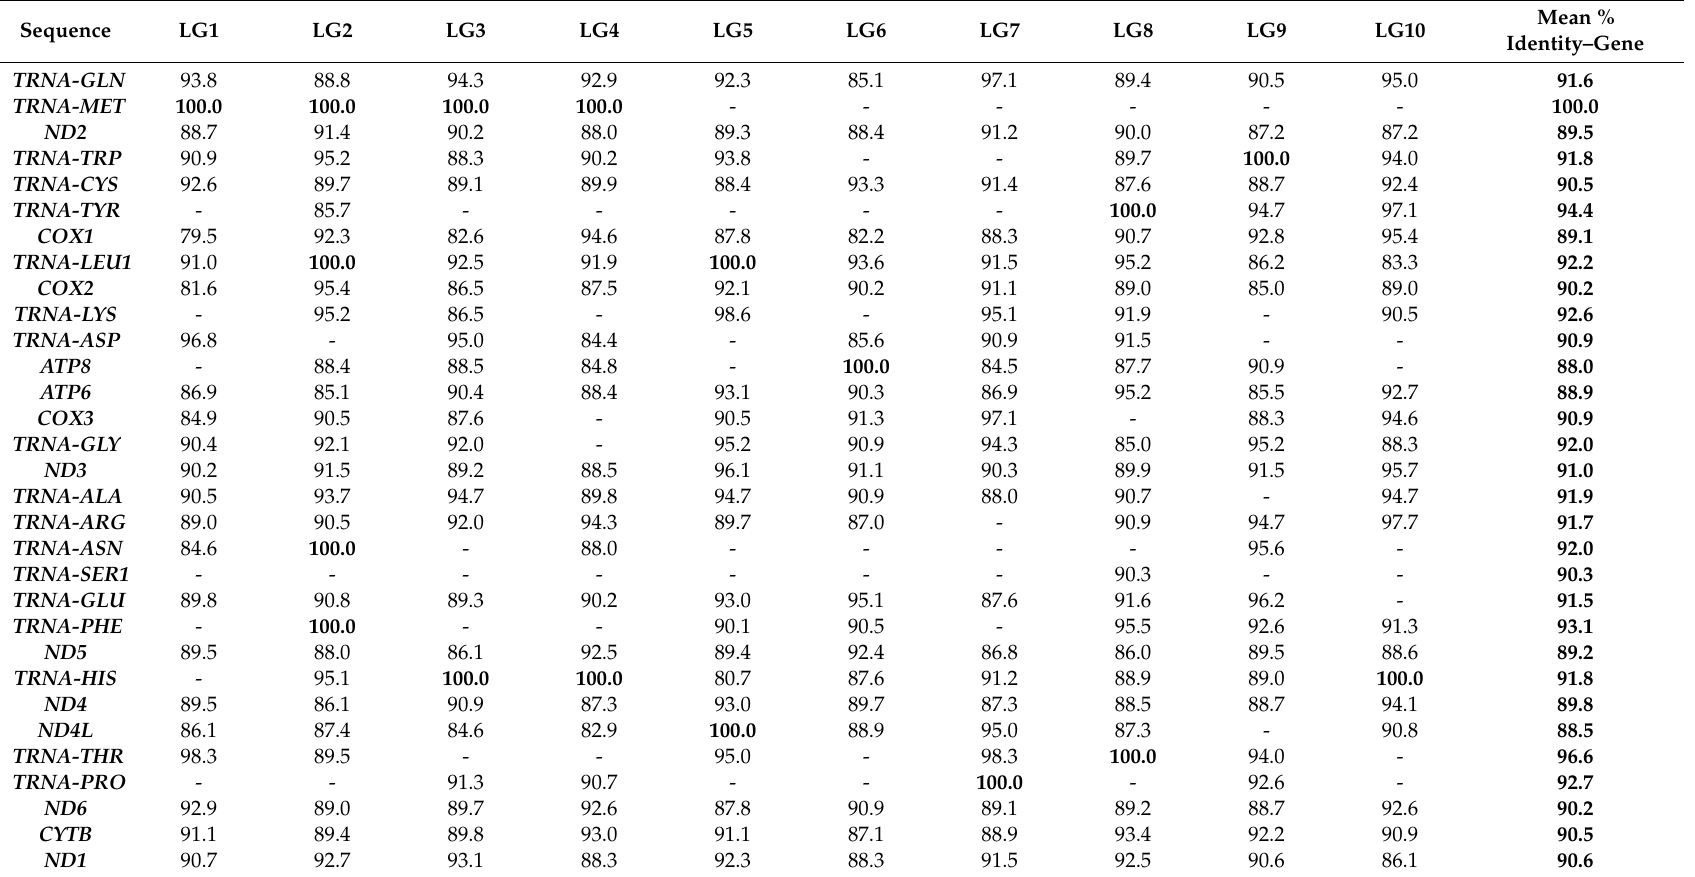
Table 4. Mean % identity of mtDNA gene fragments located in the linkage